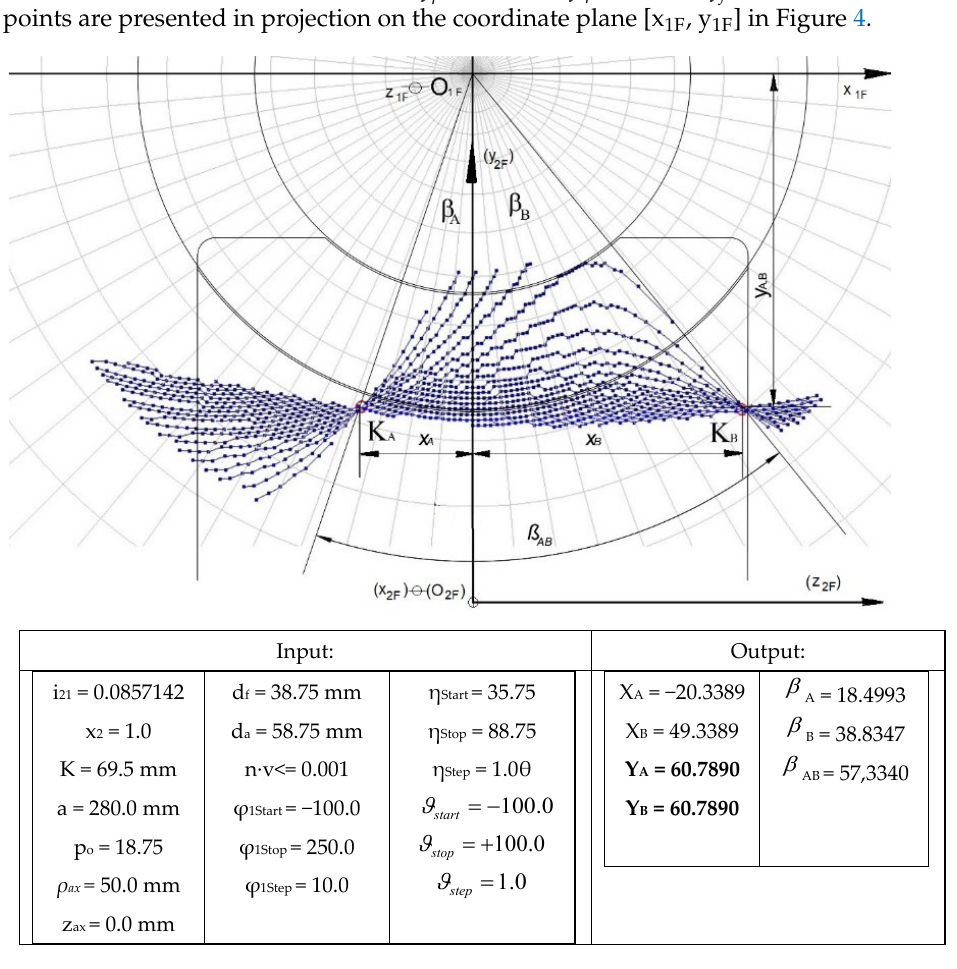
Figure 4. The projection of the contact points of the contact lines in the plane [x 2F , y 2F ] with the marked knots K A and K B , and their equal coordinates Y A and Y B indicated by highlighting. The geometric location of the nodes K A and K B occurring for each value of ϕ 1 are the lines L A and L B . The position of L A and L B curves is illustrated in Figure 5.